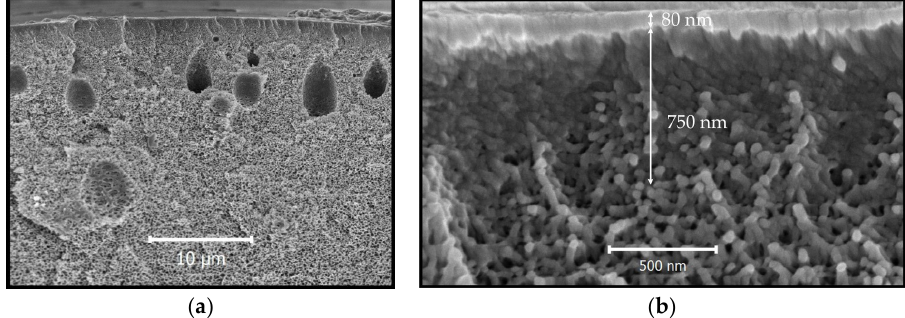
Figure 7. SEM micrographs of the aged hollow fiber cross-section with close-ups of ( a ) the wall, and ( b ) the selective layer. ( b ) the selective